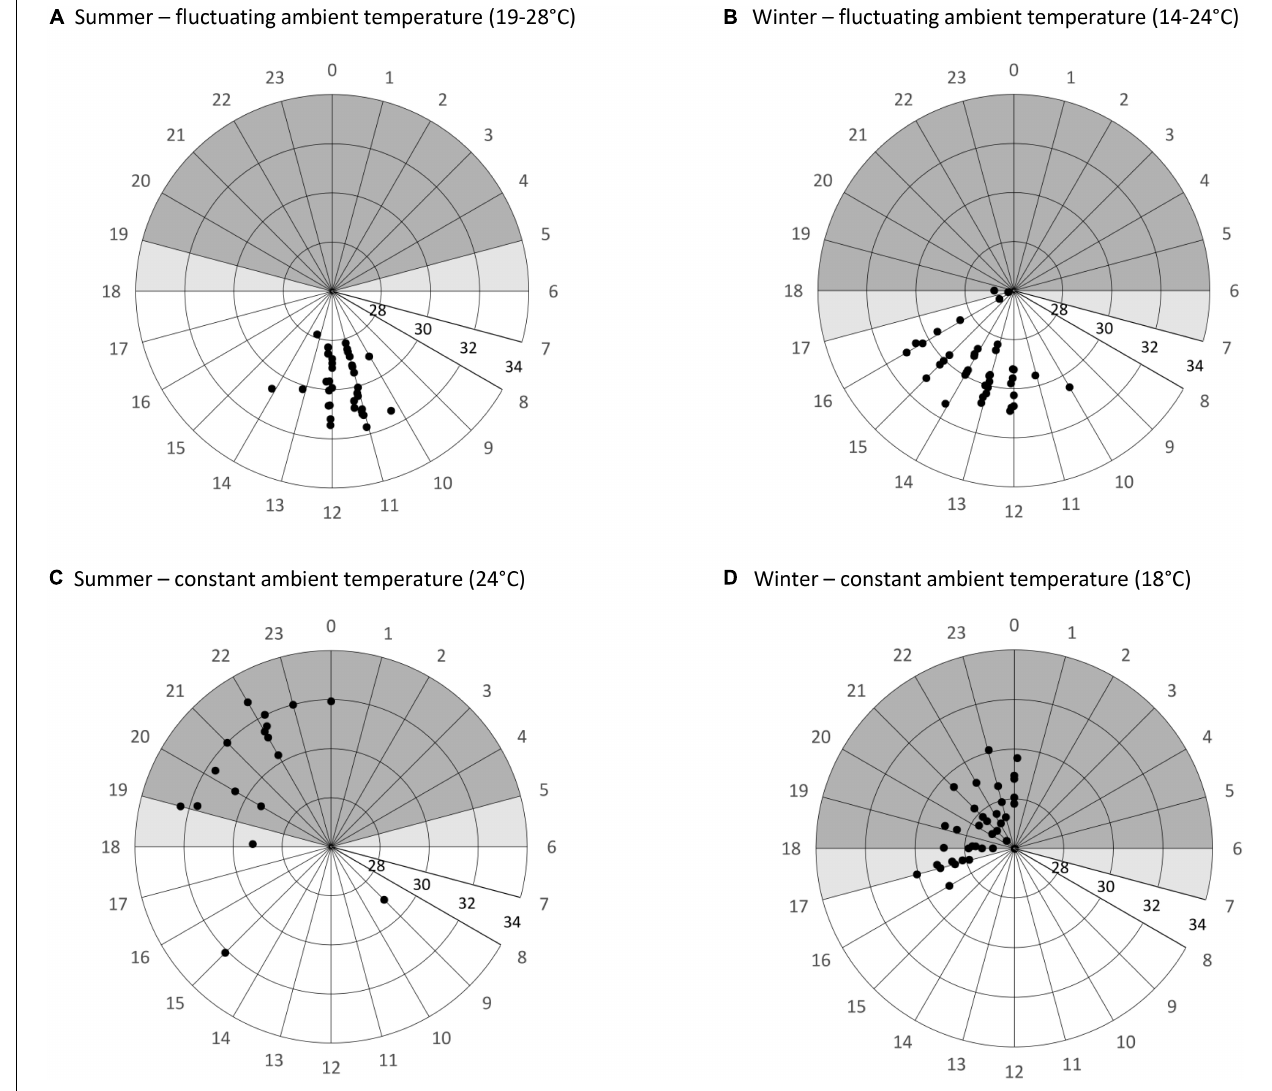
FIGURE 3 | Timing of arousals (initiation of endogenous heat production) and maximum skin temperature during arousals/activity phases of Echinops telfairi for four experimental treatments (A–D) . Data shown indicate the time of day (degrees) and level of maximum skin temperature ( ◦ C; radial distance). Shaded areas illustrate the scotophase, lighter shaded areas the transitional times between night and day phase. Under fluctuating conditions (A,B) , arousals are more synchronous and initiated when T skin passively reaches maximal T n well before the beginning of the scotophase. Under constant conditions (C,D) , the start of arousals is scattered over a longer time period, but almost always only after the beginning of the scotophase. Maximal T skin is highest during the activity phases under constant summer condition (24 ◦ C), and lowest and least variable during the arousals under constant winter conditions (18 ◦